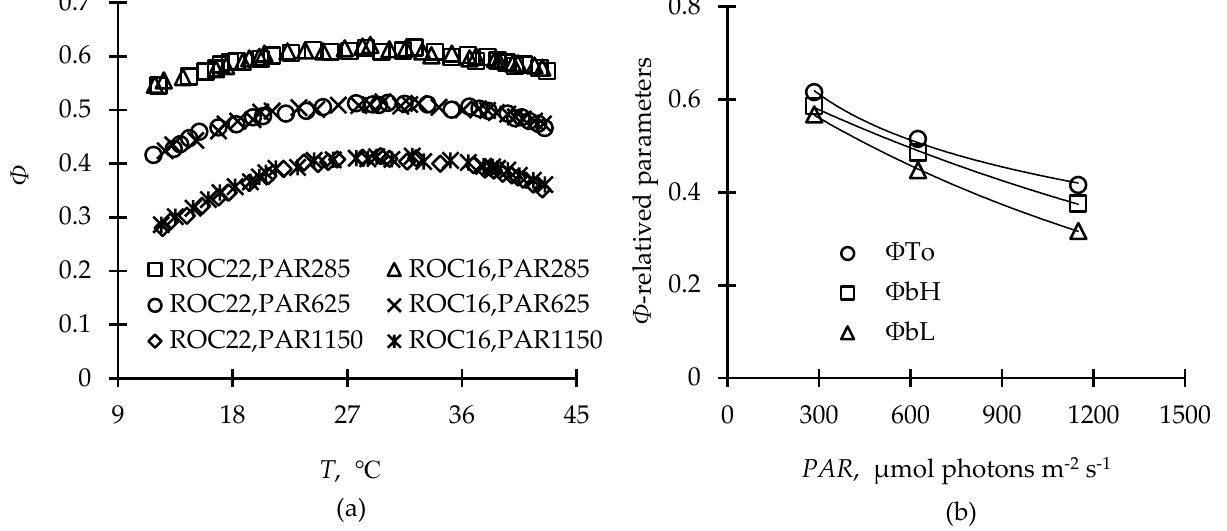
Figure 1. Response curves of photosynthetic quantum efficiency ( Φ ) to temperature ( T ) ( a ) and fitted curves of optimum Φ ( Φ To ) and basic quantum efficiency at low or high temperature ( Φ bL or Φ bH ) to photosynthetically active radiation ( PAR ) ( b ).